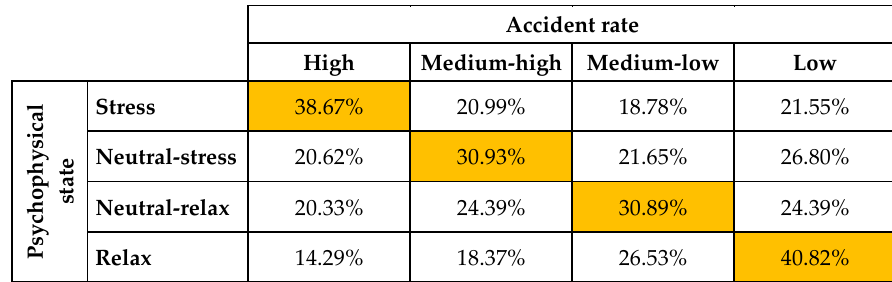
Figure 13. Correlation matrix of psychophysical status and the level of accident. Data are expressed in percentages.